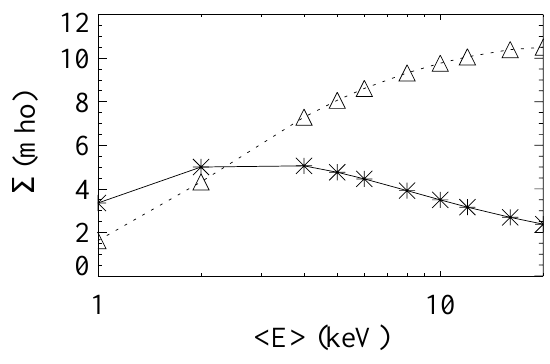
Fig. 1. Hall and Pedersen conductances due to auroral elec- trons. Conductances are evaluated for an incident energy flux of 1mW/m 2 . The Pedersen conductance is presented with stars and the Hall conductance with triangles.